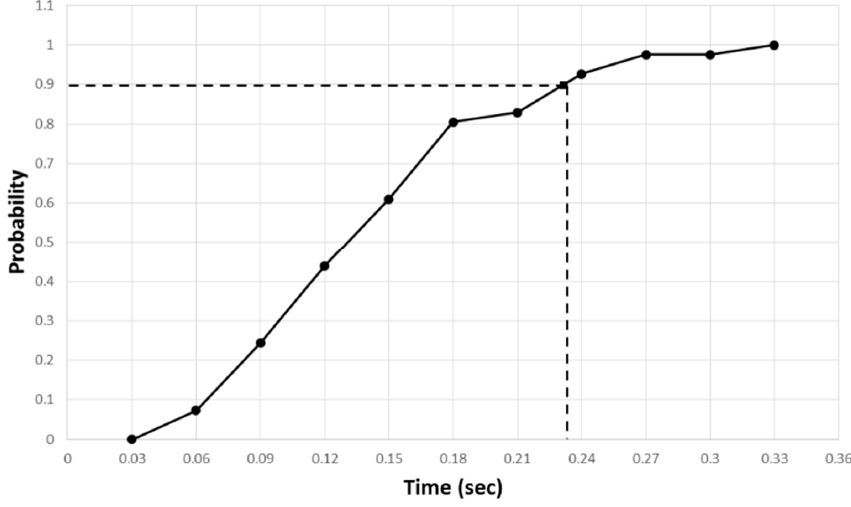
Figure 21. Cumulative distribution of reaction time interval between master and slave.